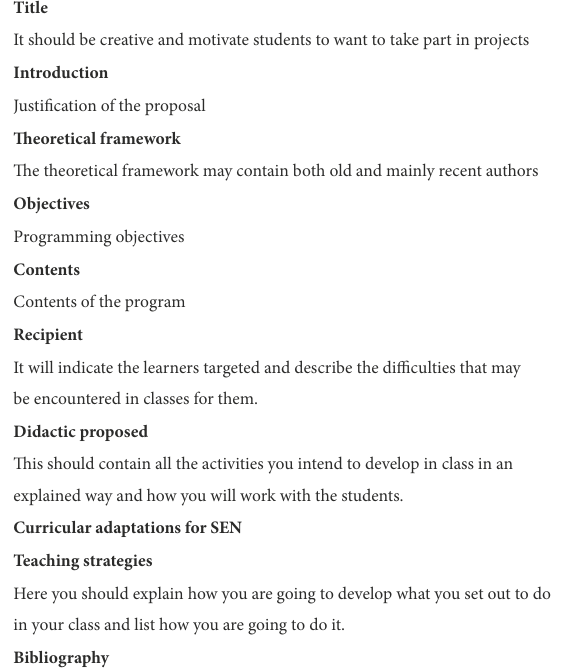
TABLE 2 Didactic guide used for the development of the